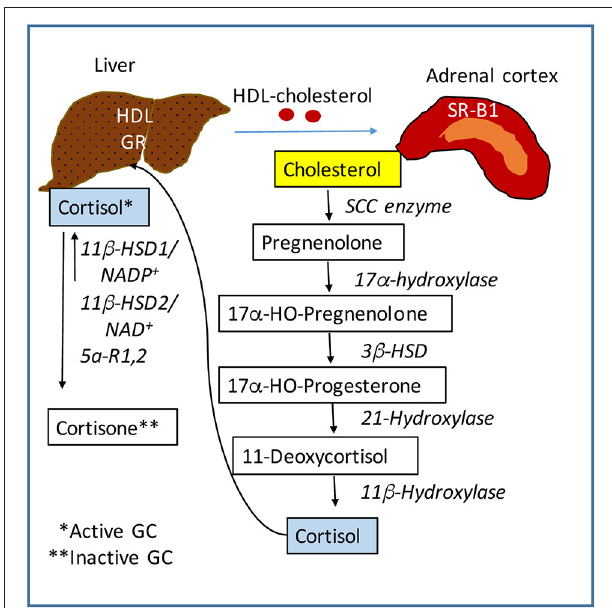
FIGURE 2 | Regulation of cortisol activity. Cortisol is synthesized starting with cholesterol. The liver controls the level of lipids including cholesterol in the systemic circulation. The adrenal glands express scavenger receptor SR-B for high density lipoproteins (HDL) which mediate the uptake of cholesterol into the adrenal cortex. A series of steroidogenic enzymes in the inner mitochondrial membrane convert cholesterol into cortisol, the main GC with biological activity. Cortisol is released into the blood circulation and is taken up into the liver by GC receptors. Cortisol is converted into cortisone which is biologically inactive, by 11 β -HSD (hydroxysteroid dehydrogenase) in the presence of NADP + . This form of 11 β -HSD can also reduce cortisone to cortisol in the presence of NADPH. The NADP + to NADPH ratio controls the activation of cortisol. SCC, side-chain cleavage enzyme. 3 β -HSD, 11 β -HSD, hydroxysteroid